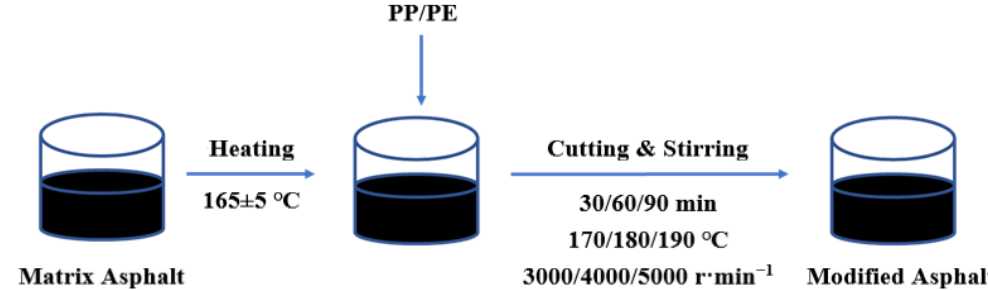
Figure 2. Preparation of plastic-modified